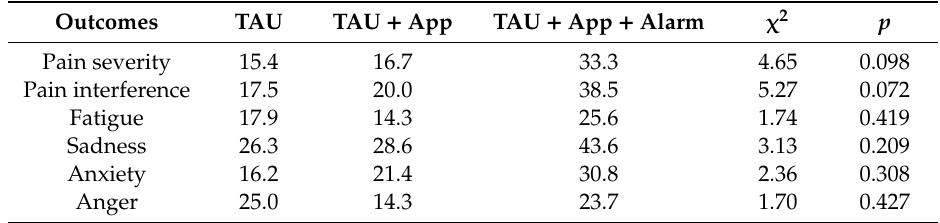
Table 2. Percentage of participants showing a clinically significant improvement in study outcomes across